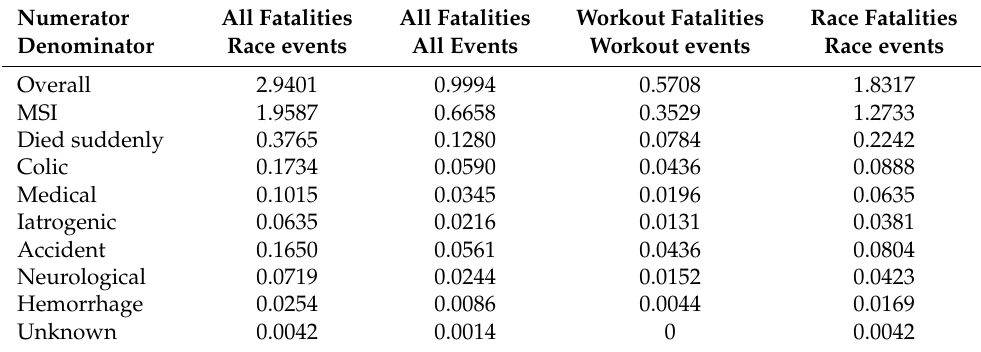
Table 3. Fatality rates in Ontario thoroughbred racing 2003–2015 according to different methods of calculation and by consolidated presenting problem *.